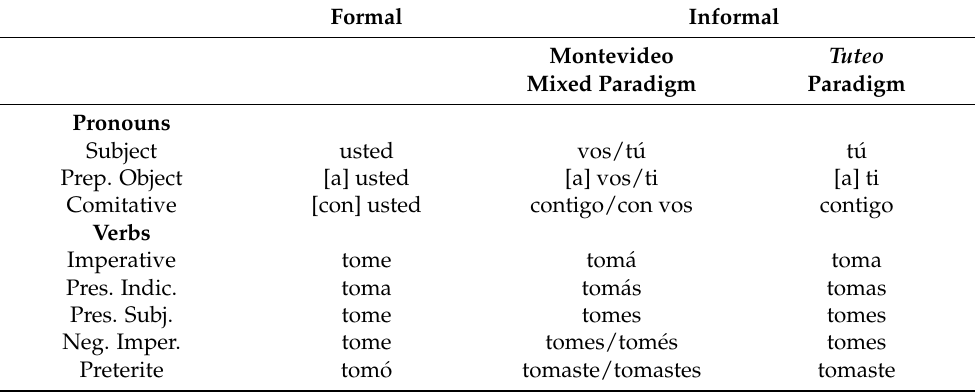
Table 1. Formal address pattern contrasted against the bipartite informal tuteo pattern and Montev- ideo’s informal paradigm. N.B.: Only three-way contrasts have been included. Formal Informal Mixed Paradigm